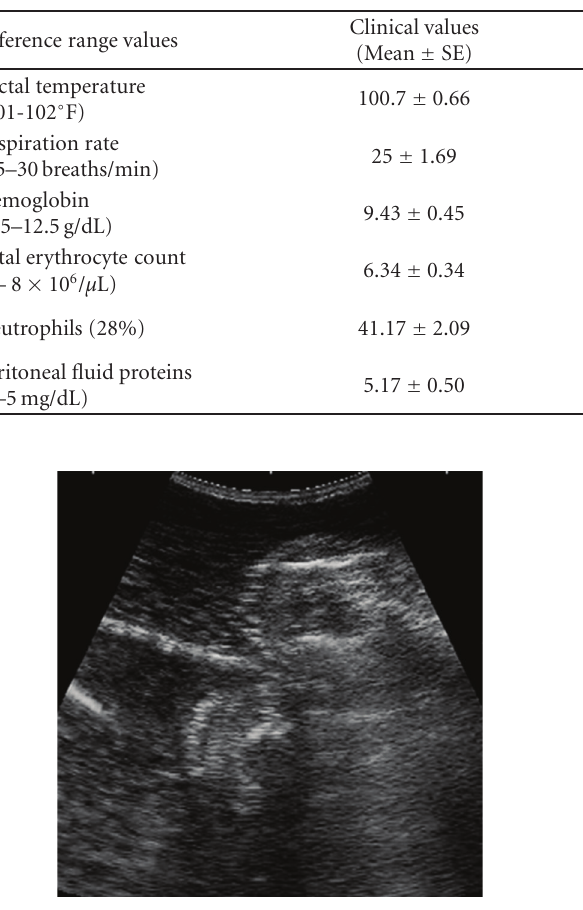
Figure 3: Ultrasonogram of a resected segment of jejunal intussus- ception in a water bath.